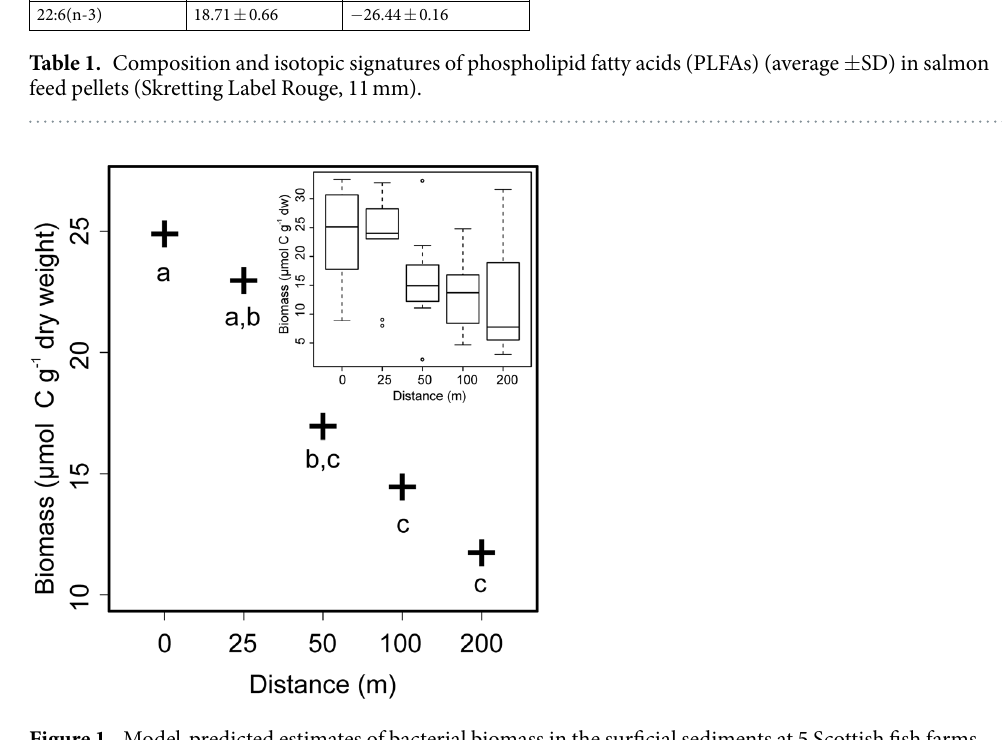
Figure 1. Model-predicted estimates of bacterial biomass in the surficial sediments at 5 Scottish fish farms illustrating the effects of distance (m) from the cage edge. Common letters ( a , b , c ) denote that distances are not significantly different from each other (p > 0.05). Inset boxplot presents the analyzed